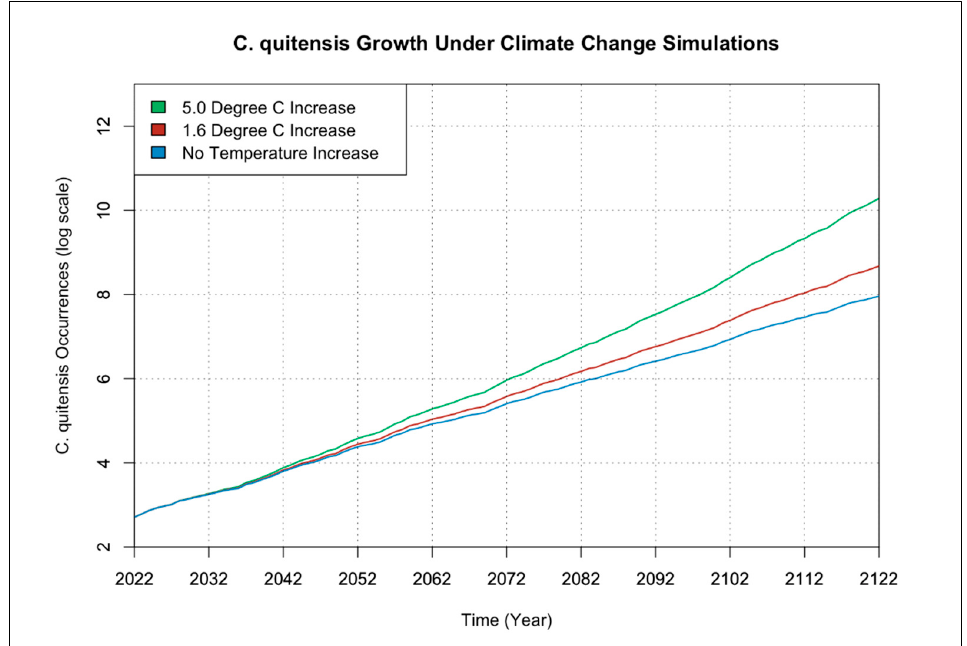
Figure 5. C. quitensis Occurrences Under No Temperature Increase, 1.6 ◦ C Temperature Increase and 5.0 ◦ C Temperature Increase Simulations